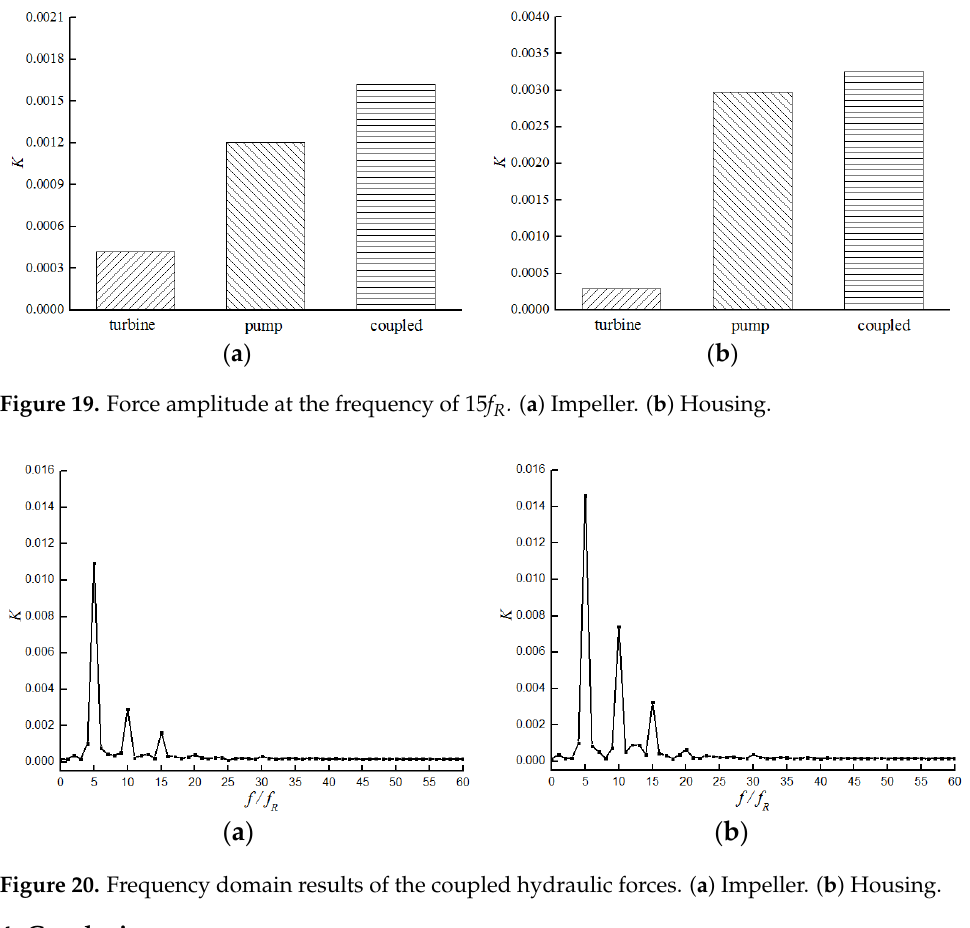
Figure 20. Frequency domain results of the coupled hydraulic forces. ( a ) Impeller. ( b ) Housing.